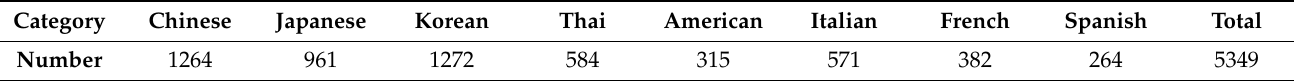
Figure 9. Comparison of classification models in terms of the macro-average precision, recall, and F1-score. Table 8. Distribution of category of the unclassified recipes as predicted by the SVM model.